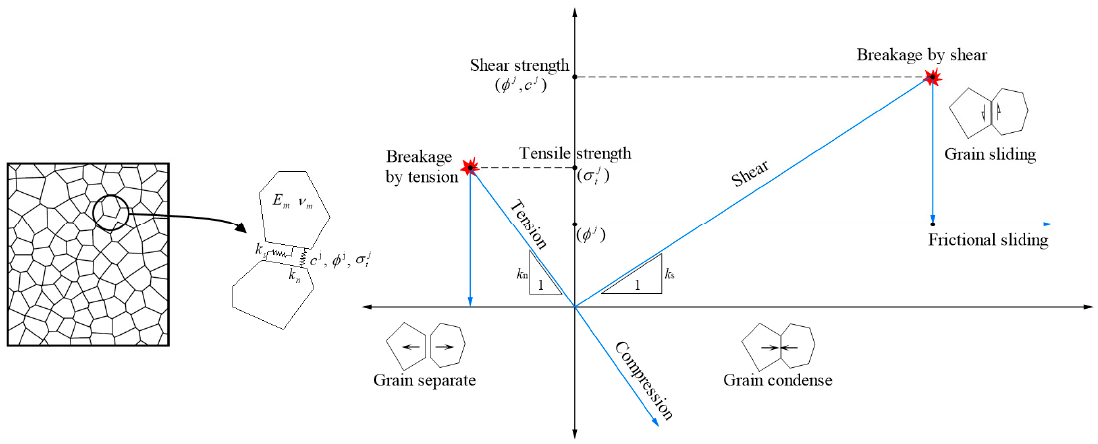
Figure 5. Voronoi model with the indication of contact micro-parameters and force–displacement and failure behavior for the contact between two blocks [24].